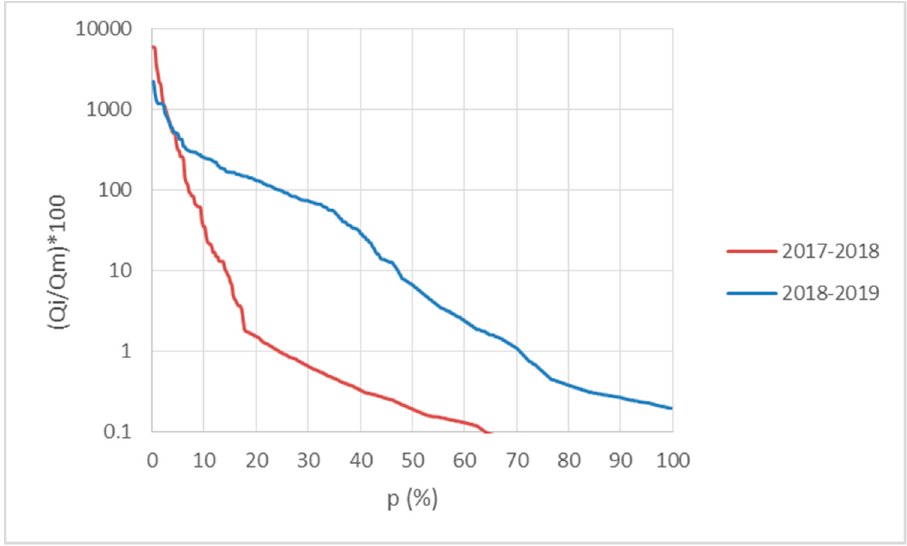
Figure 5. Flow duration curve for the hydrological years 2017–18 and 2018–19.